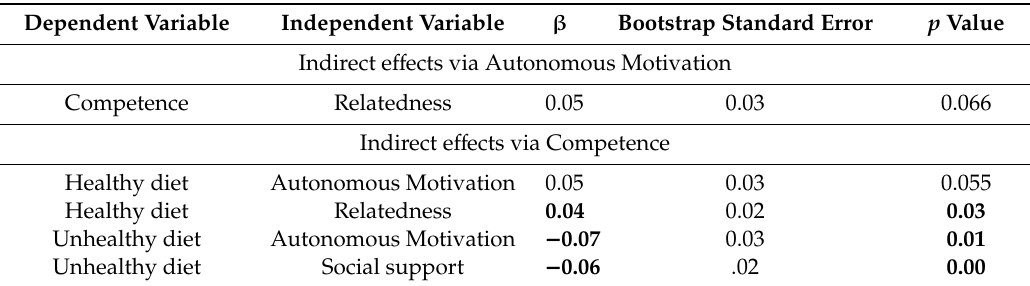
Table 6. Indirect e ff ects of the path analysis